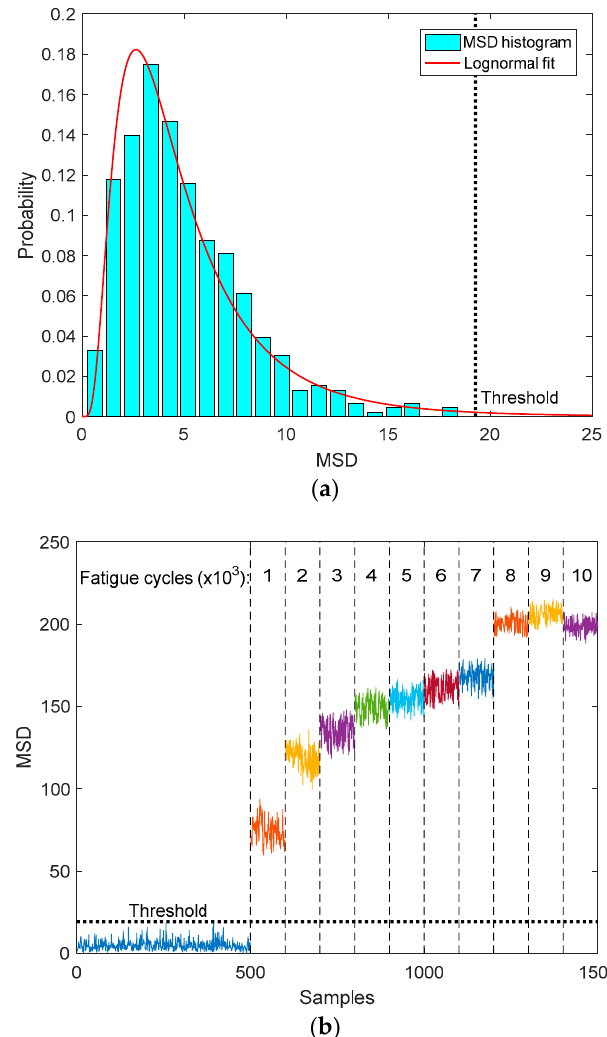
Figure 9. Outlier analysis results for specimen S_A with Level 1 contamination: ( a ) probability density function (PDF) of baseline Mahalanobis squared distance (MSD) and ( b ) MSDs for different fatigue states.